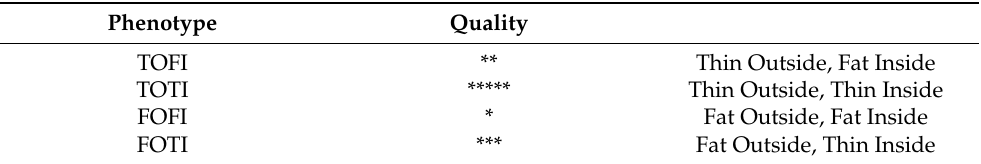
Table 3. Adipotopography: localization of adipose tissue in the human